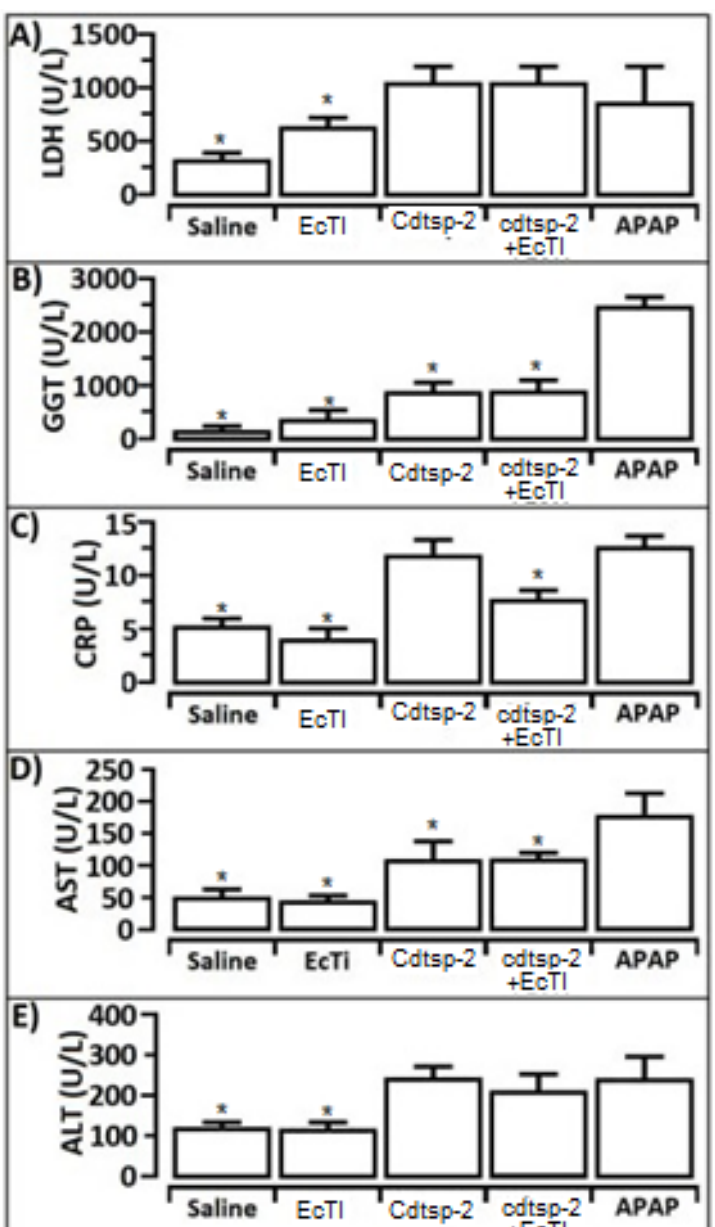
Figure 6. ( A ): It is possible to see an increase in LHD excretion in the presence of Cdtsp-2 protein when it was applied to EcTI 30 min after Cdtsp-2. ( B ): There was a significant decrease in Hepatotoxicity in relation to y-GT excretion caused by the protein when it was applied to EcTI 30 min after Cdtsp-2. ( C ): There was a significant decrease in liver inflammation caused by Cdtsp-2 protein when the same was applied to EcTI 10 min after Cdtsp-2. ( D , E ): There was no significant decrease in hepatotoxicity of the protein when it was applied to EcTI 10 min after Cdtsp-2. Data were expressed as mean and standard deviations, and treatments with significant difference marked with (*) and ANOVA was used as a statistical test, with Dunnet as a posteriori test, F = 9.797, p = 0.0017.